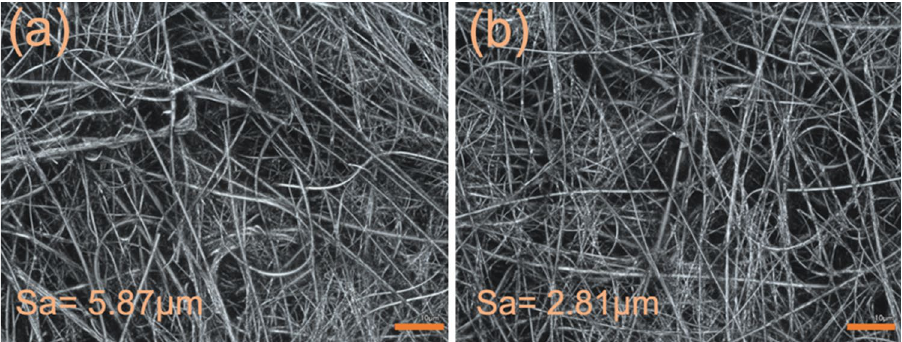
Figure 4. Confocal microscopy images of ( a ) a fresh FG filter, and ( b ) a FG filter after 3 filtration runs with backwashing and bleach decontamination. The scale bar corresponds to 10 μm.